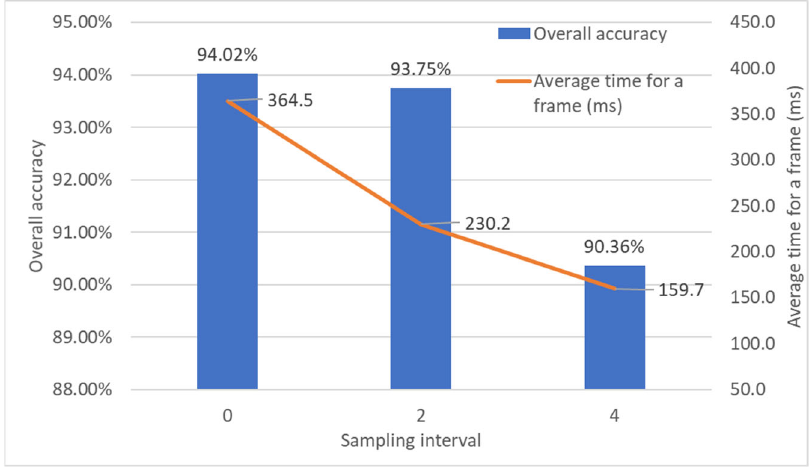
Figure 19. The performance of our method using different sampling intervals. Improving the calculation speed of the roadside LiDAR clustering of vehicles and pedestrians can reduce the delay of the urban roadside system, which is beneficial to the safety of traffic. 3D DBSCAN [8] was used in the object clustering of roadside-LiDAR point clouds on the basis of density statistics. 3D point-cloud clustering is more computationally intensive than 2D image clustering. Therefore, we propose density-adaptive DBSCAN for foreground clustering in Section 2.4. Compared to 3D DBSCAN, we reduce the dimensionality of the point cloud by projecting the 3D point cloud of the foreground point onto the ground. The background can be used to extract the road plane once, and there is no need to calculate the road plane every frame because the road plane is invariant. The method of plane re-clustering can reduce the number of calculations. Since vehicles and pedestrians are located on the road plane, the clustering of the projected point clouds on the ground has little effect on the results. We tested the effect of this method on the clustering speed and the clustering accuracy in our experiments. We compared the clustering time and the OA of traditional 3D DBSCAN and our proposed method of den ‐ sity ‐ adaptive DBSCAN in the intersection scene, as shown in Figure 20. Figure 21 shows the OA of the 3D DBSCAN and the density ‐ adaptive DBSCAN methods on vehicle and pedestrian clustering in two scenes. The experimental results show that the use of post ‐ projection clustering can improve the clustering speed by 13%, without affecting the clus ‐ tering accuracy.